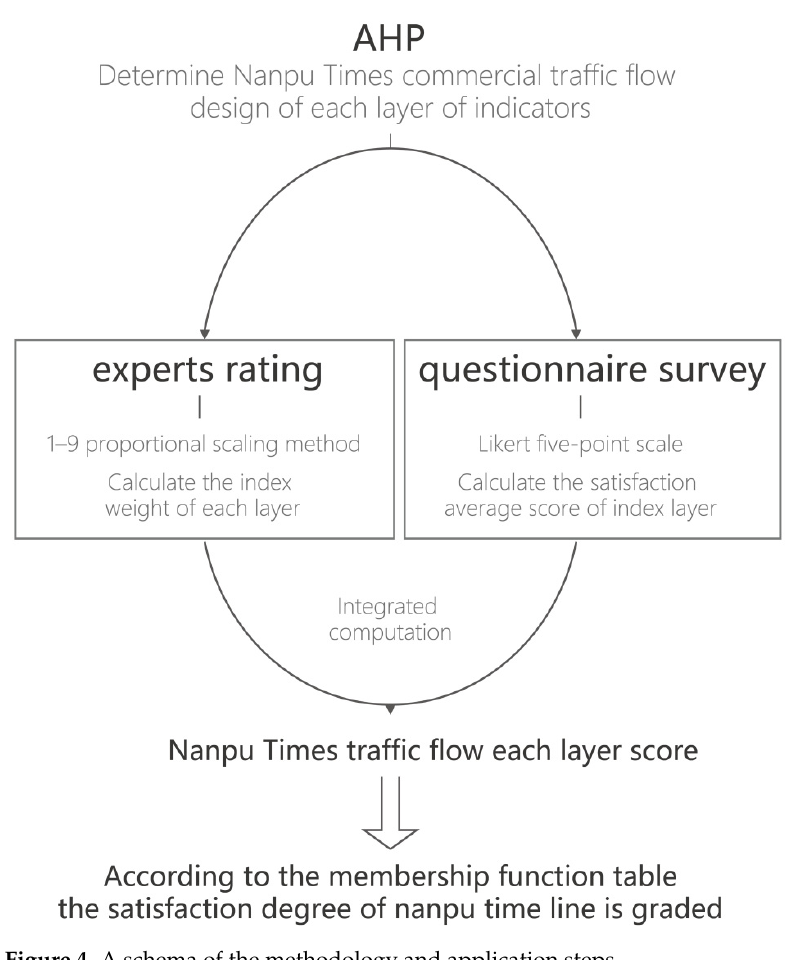
Figure 4. A schema of the methodology and application steps.